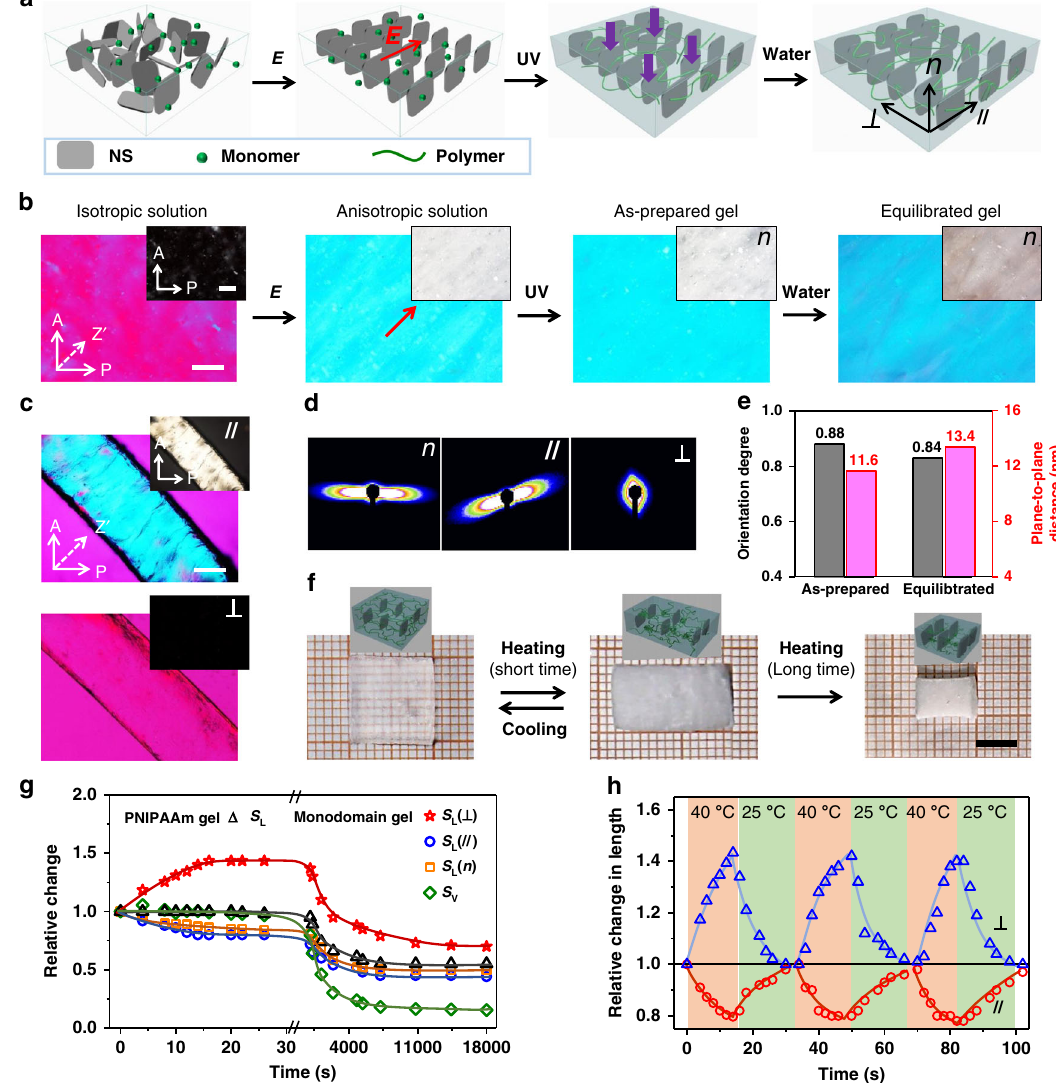
Fig. 1 Synthesis, structure, and properties of the monodomain hydrogel. a , b Schematic for the preparation of monodomain anisotropic hydrogel by electric- fi eld-induced orientation of NSs ( a ) and corresponding polarizing optical microscope (POM) images of the sample viewed from the top ( b ). A: analyzer, P: polarizer, Z ′ : slow axis of the 530 nm tint plate. c – e POM images of the sample observed from the // and ⊥ directions ( c ), 2D small-angle X-ray scattering patterns ( d ), and corresponding plane-to-plane distance and orientation dergee of NSs in the gel ( e ). f Photos and structure illustrations to show the temperature-mediated anisotropic deformation of the hydrogel. g , h Variations of the dimensions of hydrogel after transferring it from 25 to 40 °C water bath for a long time ( g ) or cyclically switching between 25 and 40 °C water baths with a short interval ( h ). S L and S V are the expansion/ contraction ratio in length and in volume of the hydrogel, respectively, with the reference state at room temperature. Scale bars in b and c are 1 mm; scale bar in f is 5